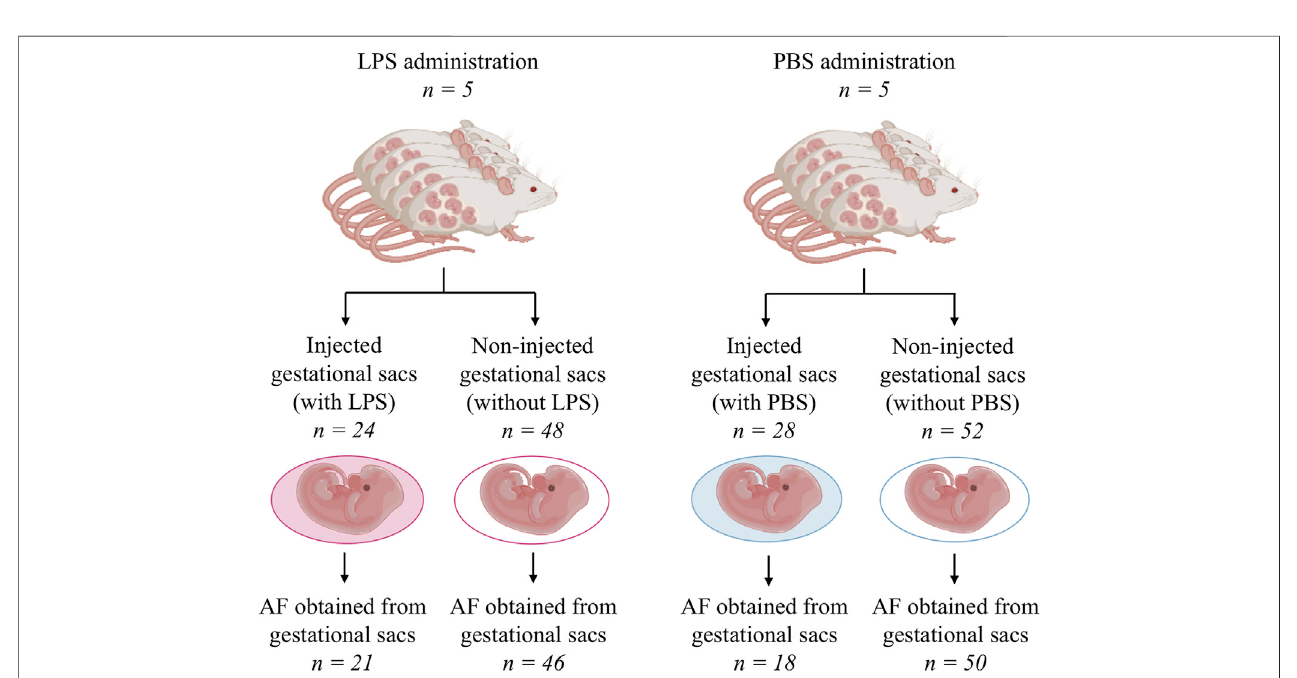
FIGURE 2 | Schema of the fl ow through the animal experiment. AF, amniotic fl uid; LPS, lipopolysaccharide; and PBS, phosphate-buffered saline.